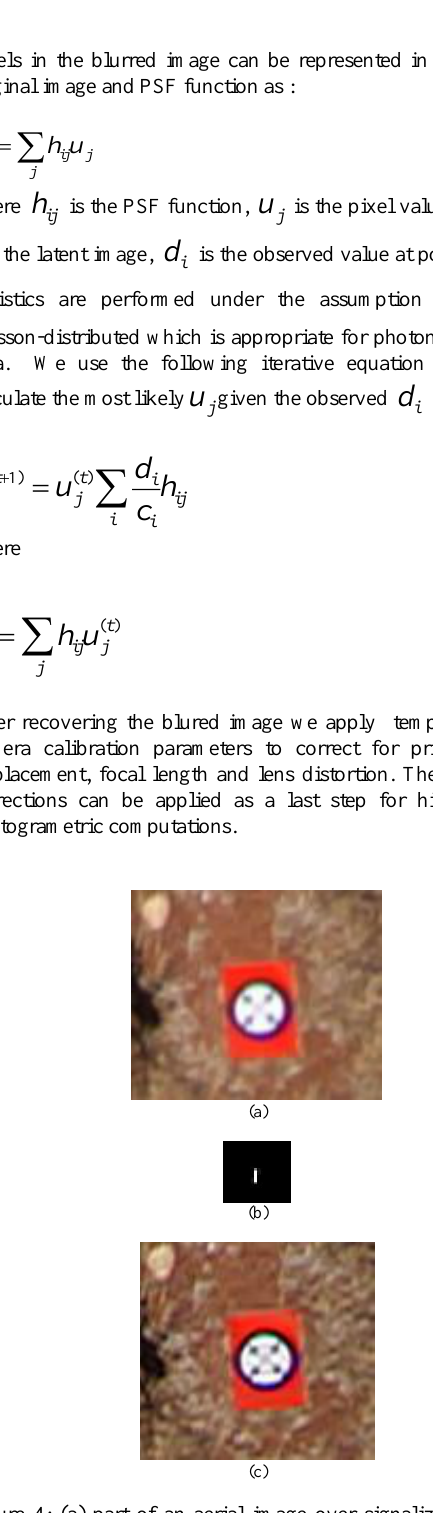
Figure 4: (a) part of an aerial image over signalized target (b) calculated PSF for 4.7 pixels, (c) corrected